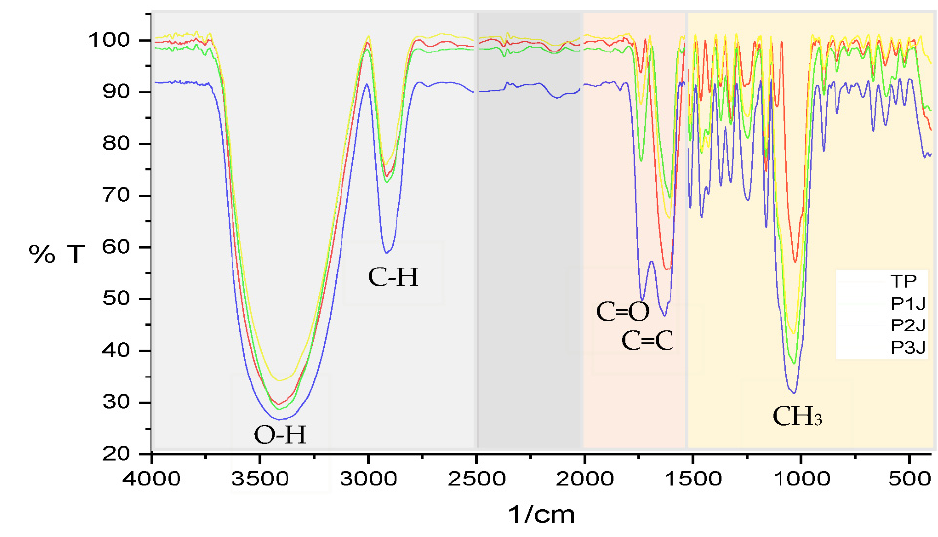
Figure 10. Transmittance comparison of FTIR test (TP, P1J, P2J, and P3J).